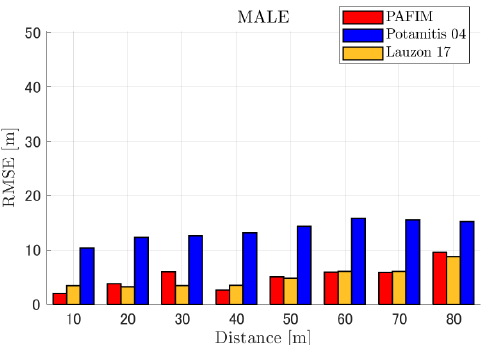
Figure 14. RMSE of tracking a sound source moving in a circle emitting male voice (focusing on SNR = − 20